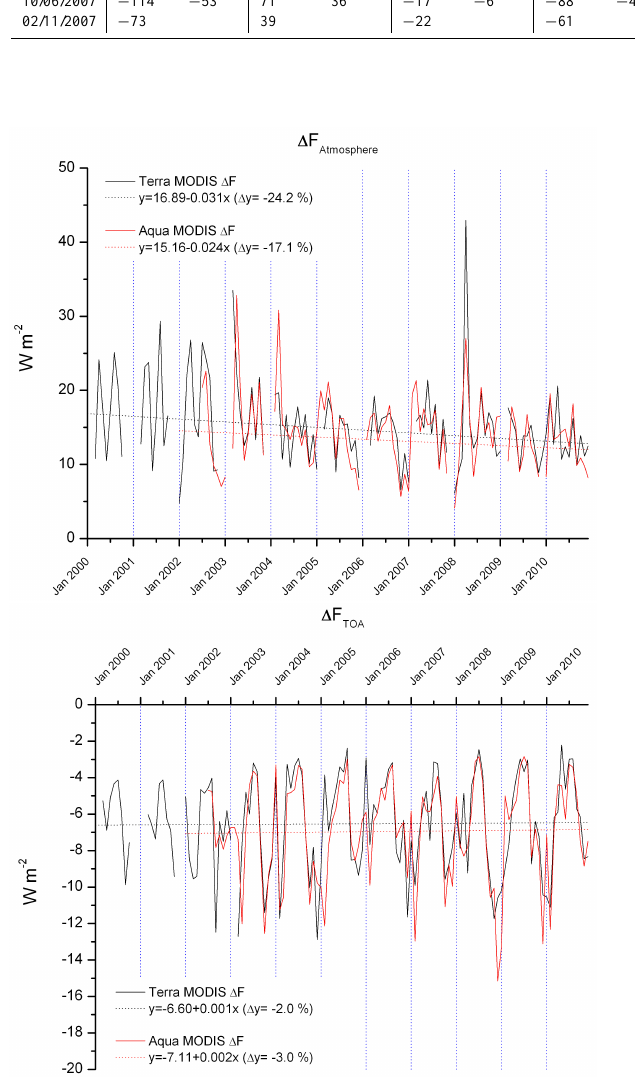
Fig. 10. As in Fig. 9, but for the aerosol DRE within the atmosphere (a) and at TOA (b)